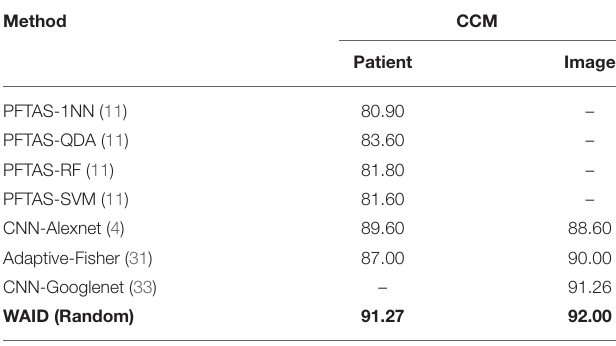
TABLE 4 | Comparisons against state-of-the-art on